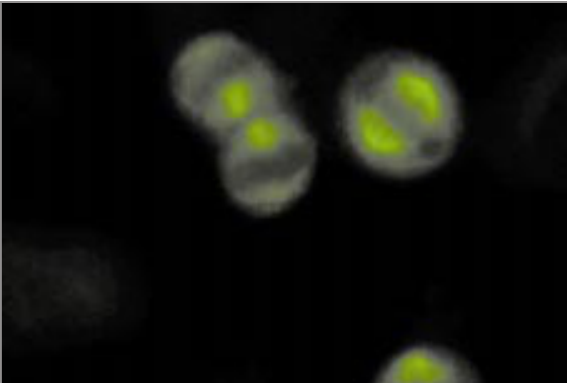
Figura 20 – Citoplasmático pontilhado reticulado